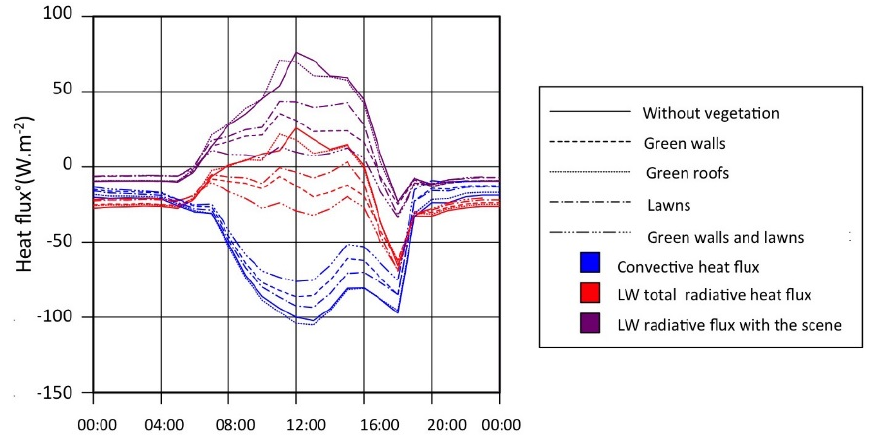
Figure 16. Mean values of convective and radiative heat fluxes over the entire third floor external surface. LW, long wave.